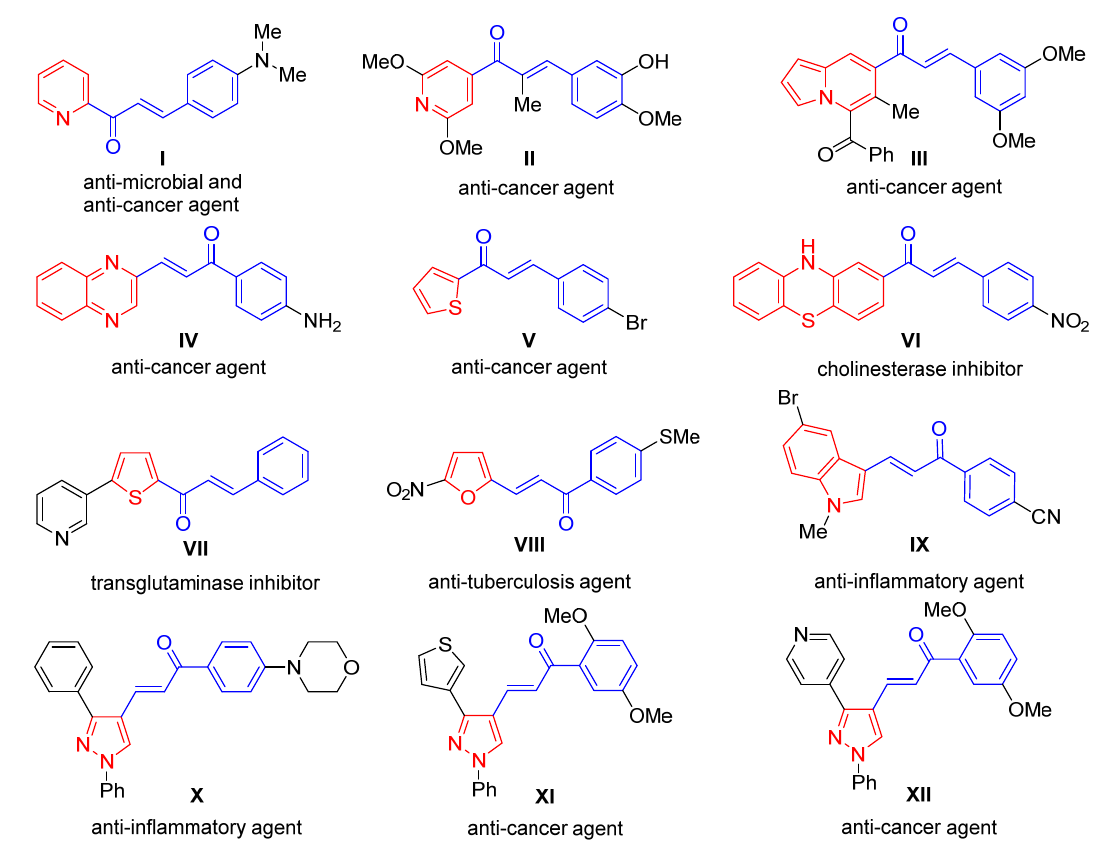
Figure 1. Selected examples of heterocyclic chalcone derivatives for some biological applications.